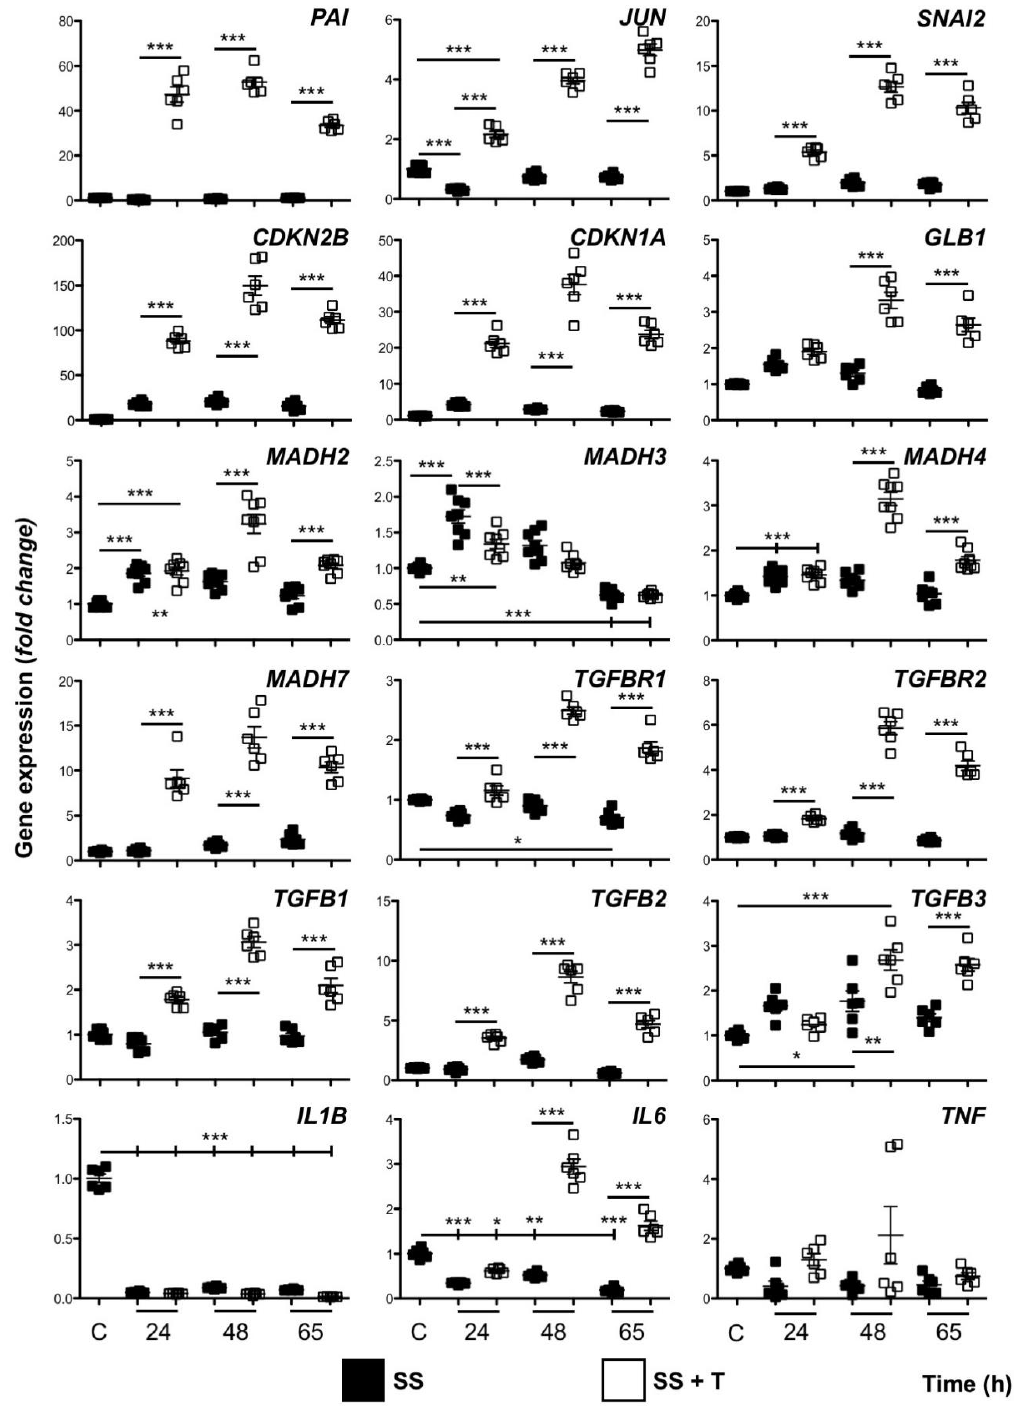
Figure 2. Gene transcription evolves throughout extended treatments with TGF- β 1. HaCaT cells maintained in serum-deprived conditions were exposed to 2 ng / mL TGF- β 1 for the indicated periods of time. Culture medium and TGF- β was refreshed every 24 h. Cells growing in full medium containing fetal bovine serum were used as reference controls C. Expression level data are represented as fold change from control samples. Replicates from three independent experiments were quantified by qPCR. Shown data represent mean ± SEM. Asterisks denote statistically significant differences (* p < 0.05, ** p < 0.005 and *** p < 0.001). SS: serum starvation; + T: TGF- β 1 exposure.